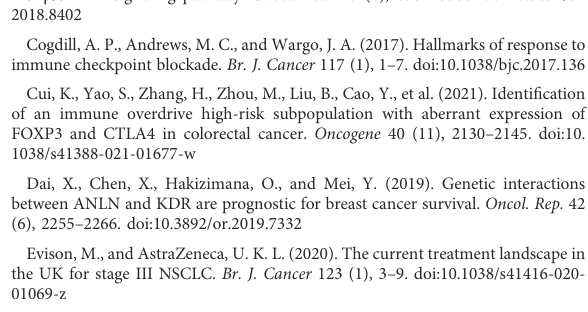
SUPPLEMENTARY FIGURE S4 The relationship between the expression levels of FOXP family and clinicopathological stages. AuthorAnonymous, (A-L) The Box plots show thedifferentialexpressionofFOXP3betweendifferentstagedtissuesof LUAD/ LUSC and normal tissues. SUPPLEMENTARY FIGURE S5 The relationship between the expression levels of FOXP family and clinicopathological stages. AuthorAnonymous, (A-L) The Box plots show thedifferentialexpressionofFOXP4betweendifferentstagedtissuesof LUAD/ LUSC and normal tissues. SUPPLEMENTARY FIGURE S6 The relationship between the expression of FOXP family and survival in LUSC. (A) The survival curves re fl ected the relationship between the patients ’ overall survival (OS) rate and the corresponding gene expression levels of FOXP1 in LUSC. (B) The survival curves re fl ected the relationship between the patients ’ overall survival (OS) rate and the corresponding gene expression levels of FOXP2 in LUSC. (C) The survival curves re fl ected the relationship between the patients ’ overall survival (OS) rate and the corresponding gene expression levels of FOXP3 in LUSC. (D) The survival curves re fl ected the relationship between the patients ’ overall survival (OS) rate and the corresponding gene expression levels of FOXP4 in LUSC. SUPPLEMENTARY FIGURE S7 The relationship between the degree of immune factor in fi ltration in NSCLCandtheexpressionofFOXPfamily. (A) Thehotmappresentedthe correlations between FOXP family and chemokine. (B) The hotmap presented the correlations between FOXP family and